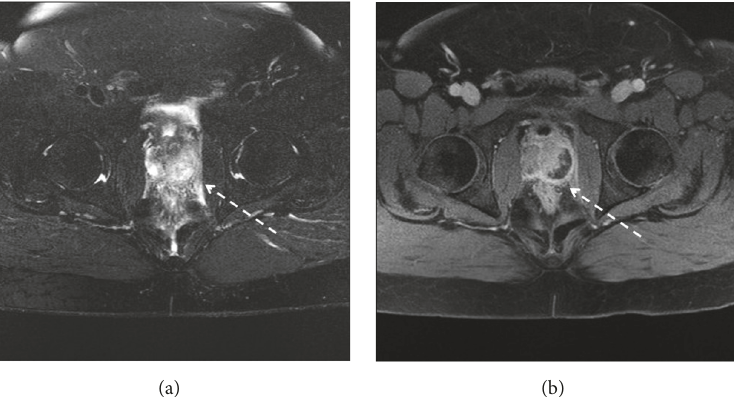
Figure 3: MRI of pelvis: axial FS T2WI (a), axial postcontrast T1WI (b). Before aspiration and antibiotic therapy showing fluid intensity lesion within posterolateral aspect of the gland measuring 24 × 12 × 14mm with marginal enhancement (prostatic abscess).